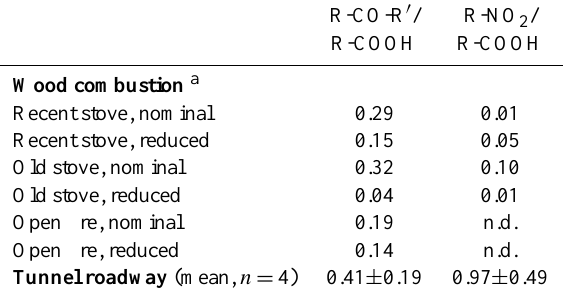
Table 3. Carbonyl to carboxylic and nitro to carboxylic molar ra- tios in different wood combustion devices and in the road traffic emissions collected in the tunnel, Marseille